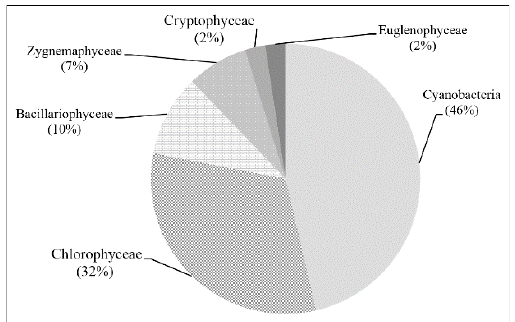
Figure 2. Distribution of phytoplankton taxonomic classes in Sítios Novos Reservoir (Ceará, Brazil) over the course of 18 months (from January 2010 to June